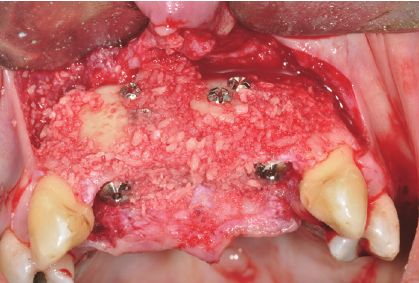
Figure 1: Maxillary: preoperative view.